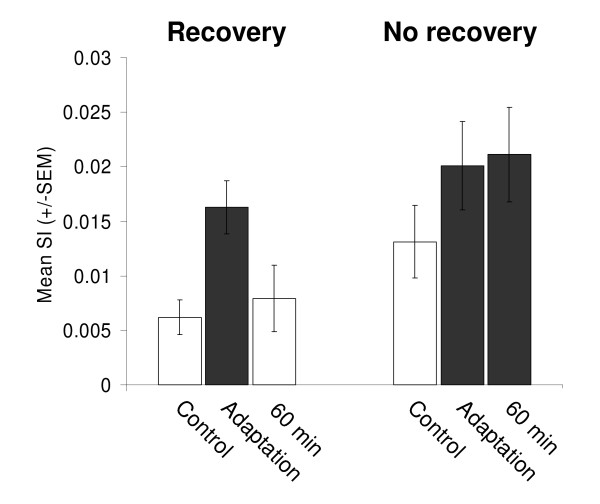
Comparison of synchrony modulation between neuron pairs that recovered and neuron pairs that failed to recover their initial preferred orientation difference. Two levels of synchrony were expected, low (white bars) and high (black bars). The low level of synchronization would be associated to the initial preferred orientation difference. The high level would be associated to the newly acquired, smaller preferred orientation difference. To verify our hypotheses, we tested with a nested ANOVA (1) the difference of the means between the 2 groups (F = 14.90, p < 0.001), and (2) the difference of the means within each group (F = 0.37, p = 0.69). The pairs that displayed recovery (n = 18 SI values) had a significant increase of synchrony followed by a full return to control level within 60 minutes. On the other hand, the pairs that failed to recover their initial preferred orientation difference also showed a significant increase of synchrony after adaptation, but that synchrony level remained high 60 minutes after adaptation.